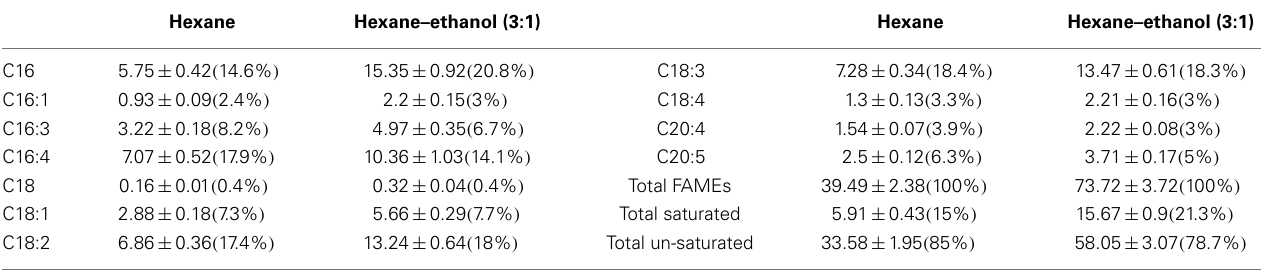
Table 2 | Quantitative fatty acid profiles determined from FAME analyses by GC-MS of Soxhlet-extracted lipids from lyophilized biomass of Tetraselmis sp. M8 using hexane or hexane–ethanol (3:1)